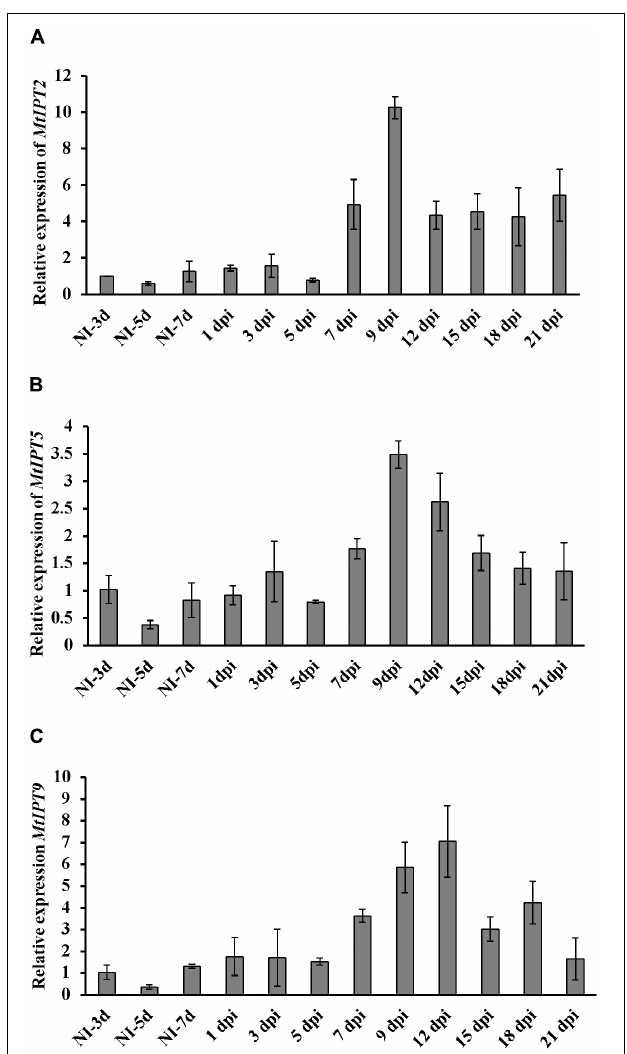
FIGURE 3 | qRT-PCR expression analysis of MtIPT2 (A) , MtIPT5 (B) , and MtIPT9 (C) in non-inoculated roots (NI) and at different days post inoculation (dpi) in wild type plants (A17). The relative expression was normalized against constitutively expressed M. truncatula actin gene. Results are mean ± SEM of three technical repeat of one biological repeat, representative for three independent